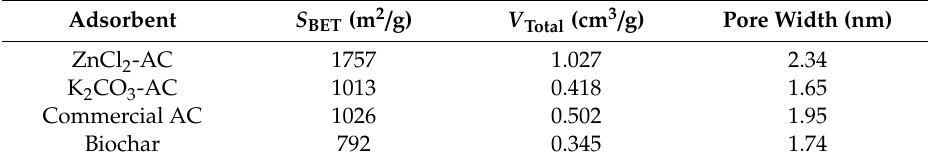
Table 1. Textural property of the prepared biochar and two activated carbon (AC) samples and CAC.